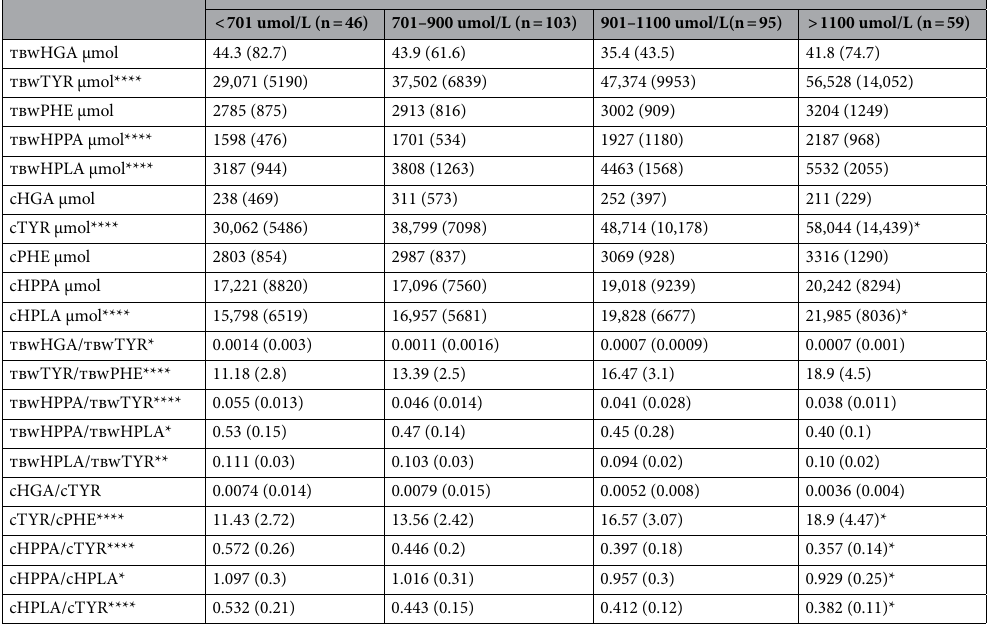
Table 2. Derived metabolic data stratified according to sTYR groups in NIT-treated AKU patients. The total body water (TBW) and combined (total body water and 24-h urine) derived data are shown according to sTYR intervals of < 701, 701–900, 901–1100 and > 1100 µmol/L. Variation among column means is significantly greater than expected by chance with p < : * < 0.05; ** < 0.01; *** < 0.001; **** < 0.0001; within sTYR group comparisons are shown in figures (main and supplementary. TBW, total body water; c represents combined TBW plus 24-h urine values; HGA, homogentisic acid; TYR, tyrosine; PHE, phenylalanine; HPPA, 4-hydroxyphenylpyruvate; HPLA,